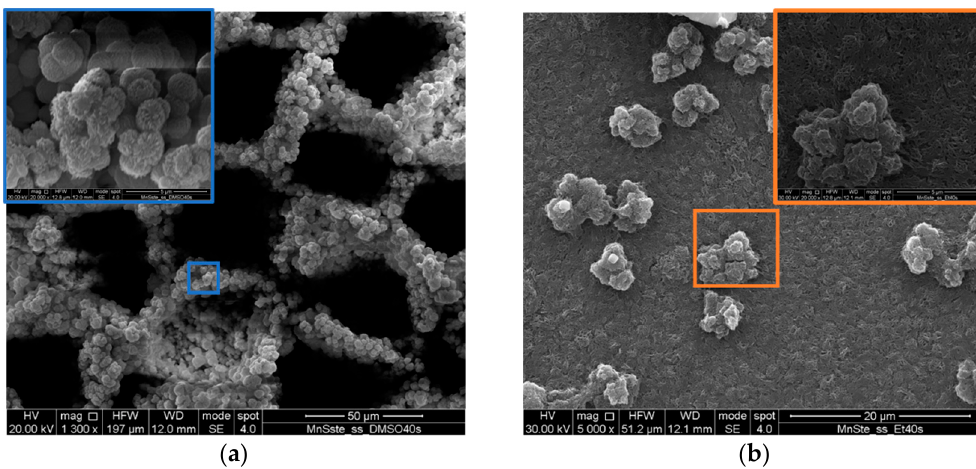
Figure 2. SEM micrographs of SS samples coated by using ( a ) DMSO and ( b ) Ethanol as solvent in the electrodeposition process. Inset: higher magnification SEM micrograph.